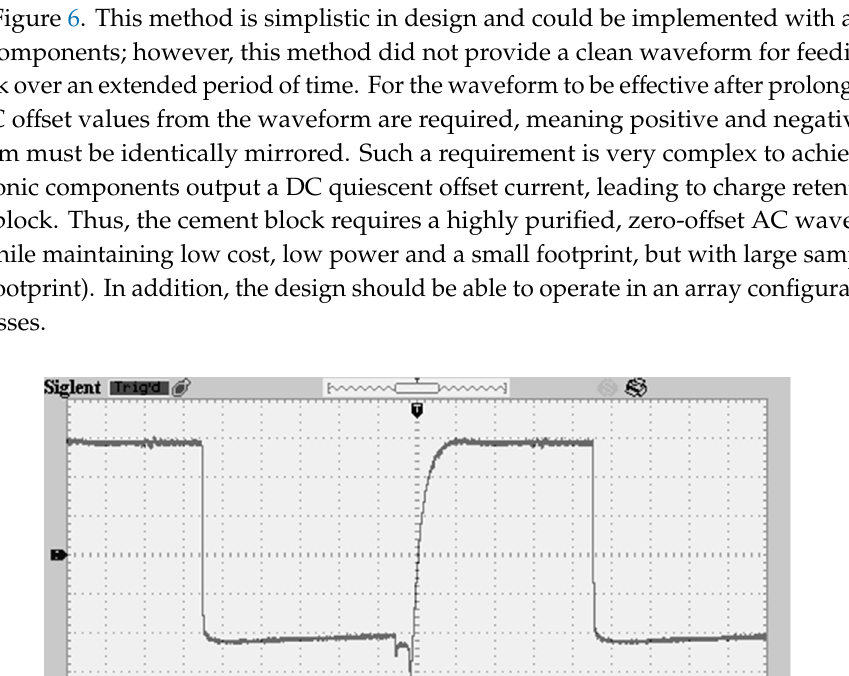
Figure 5. Electronics schematics of the sensing device.